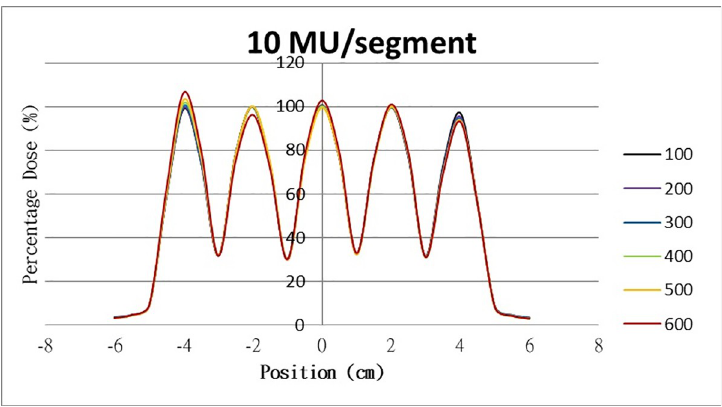
Fig 15. Overshoot effect measured at various MU values and dose rates. Overshoot effect, at various dose rates, for (6) 1 MU, (7) 2 MU, (8) 3 MU, (9) 4 MU, (10) 5 MU, (11) 6 MU, (12) 7 MU, (13) 8 MU, (14) 9 MU, (15) and 10 MU.